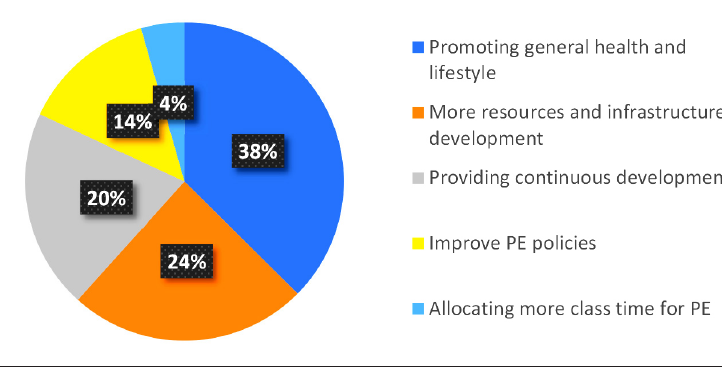
Figure 2. Strategies for changing the delivery and culture of